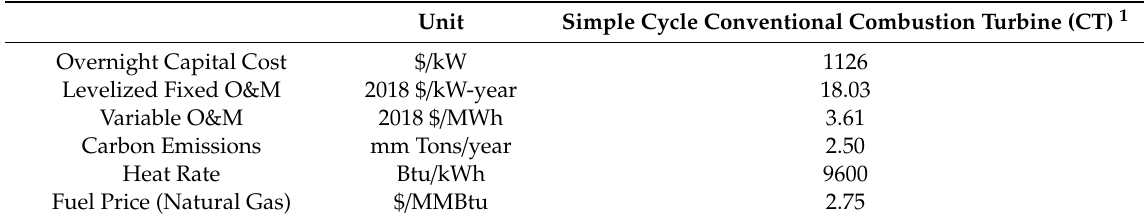
Table A6. Unitized cost assumptions for simple cycle (Conventional Turbine) power